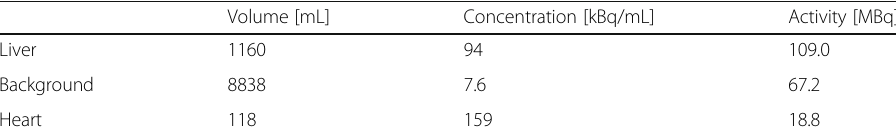
Volume [mL] Concentration [kBq/mL] Activity [MBq] Liver 1160 94